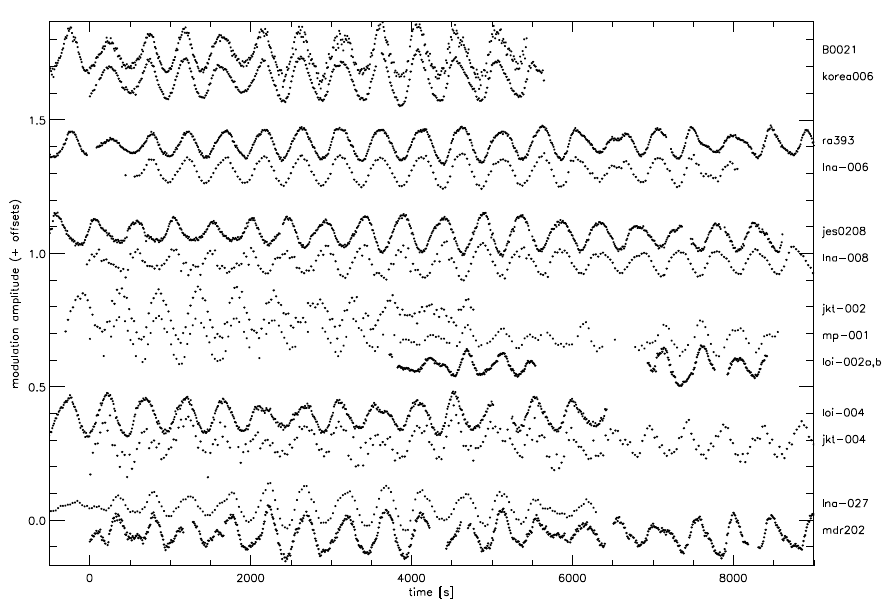
Fig. 2. Overlapping data; see text for